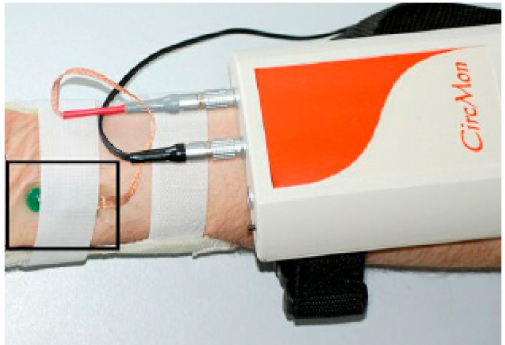
Figure 4. Noninvasive cardiovascular circulation monitor CircMon.